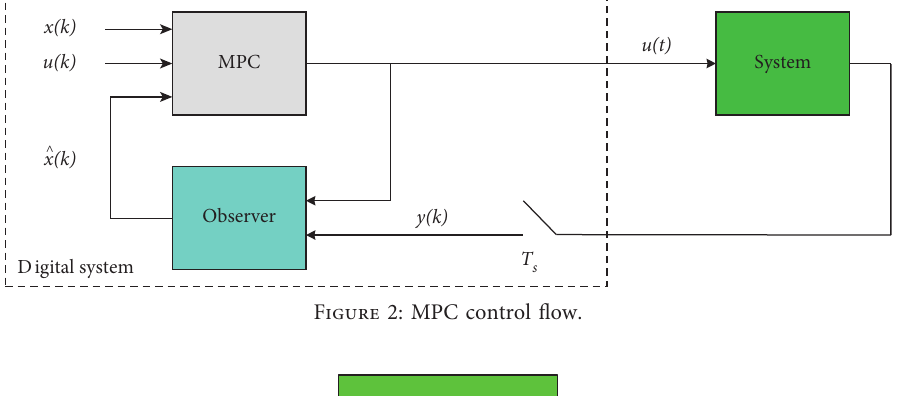
Figure 2: MPC control flow.